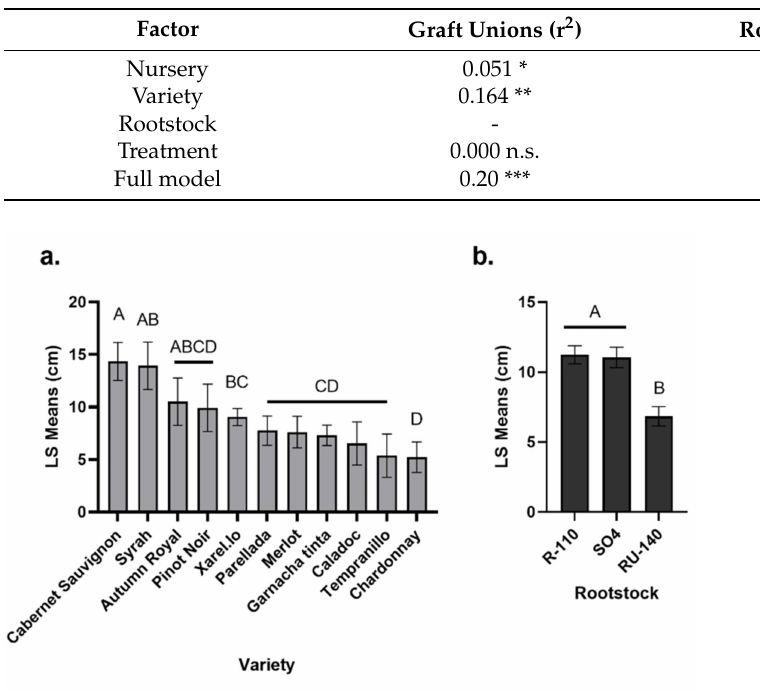
Figure 2. ( a ) Mean necrosis length (LS; cm) in graft unions for each variety; ( b ) Mean necrosis length in root collars of each rootstock. Post-hoc comparisons using a Student’s t -test were performed: values with different letters are significantly